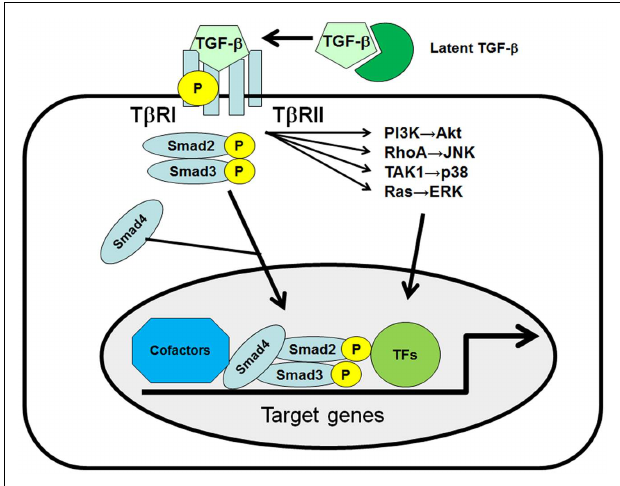
FIGURE 1 |TheTGF- β signaling pathway. Three distinct forms ofTGF- β , TGF- β 1, - β 2, and - β 3, can bind to the heterodimericTGF- β receptor complex, consisting of the type I receptor (T β RI) and type II receptor (T β RII). Once TGF- β 1 binds to the receptor complex, intracellular Smad2 and Smad3 are recruited and phosphorylated byT β RI at their C-terminal SSXS motif. Phosphorylated Smad2 and Smad3 subsequently bind to Smad4 and translocate to the nucleus to initiate target gene expression in collaboration with co-factors and other transcription factors (TFs).TGF- β can also activate the PI3K, RhoA,TAK1, and Ras/MAPK pathways in a Smad-independent